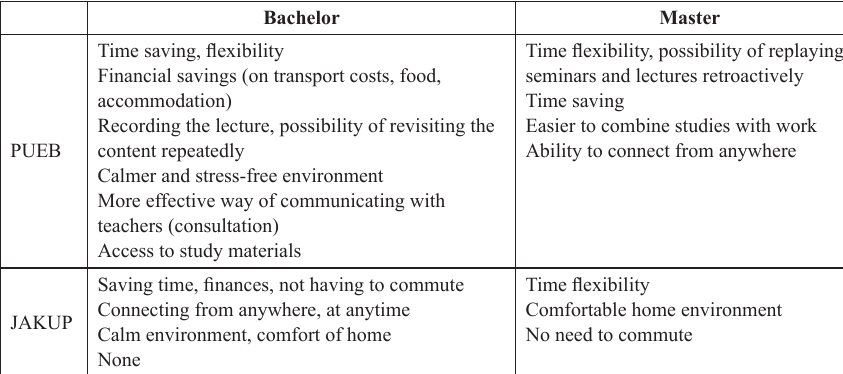
Table 4. From the perspective of students, what are the advantages of distance